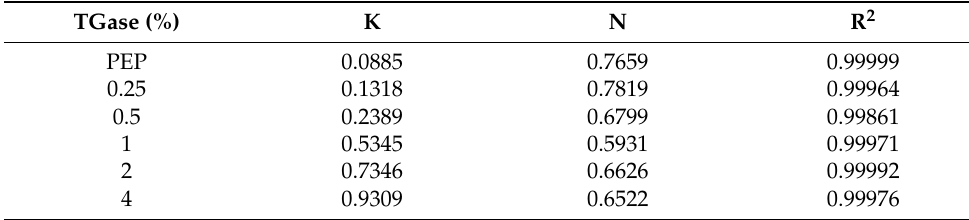
Table 3. Power-law model of PEP with different TGase content (0.25, 0.5, 1, 2, 4%).